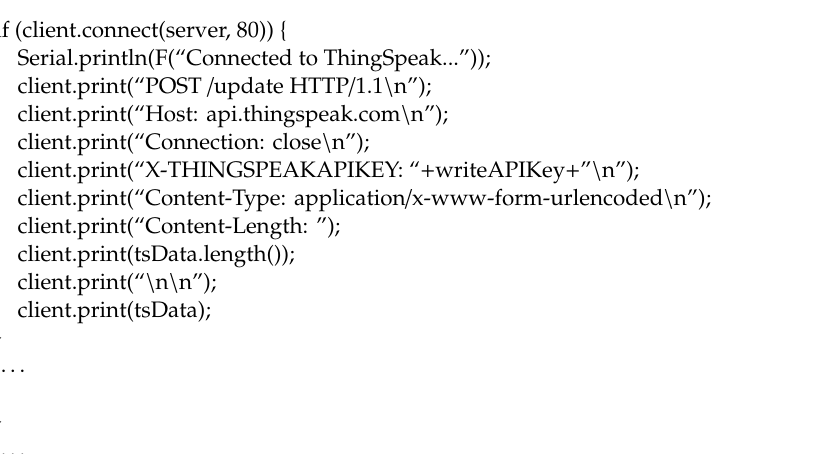
Table 3. Field of RMSPower and peakPower (turn-on transient power consumption) in ThingSpeak TM .